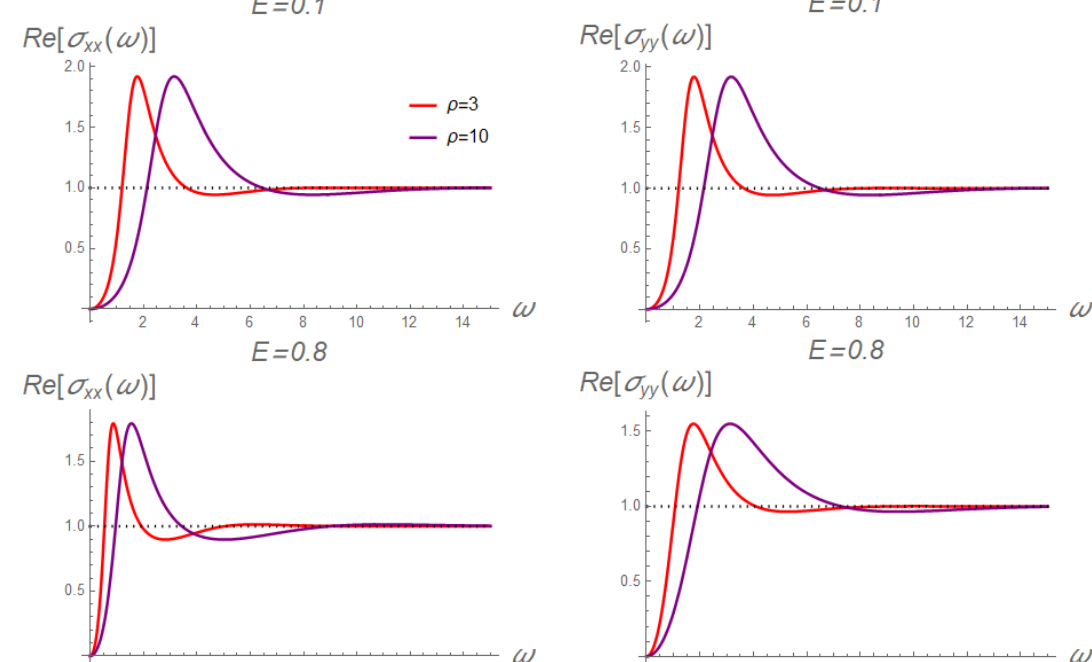
Figure 5 . Real parts of the conductivities for di(cid:11)erent values of electric (cid:12)eld E and charge density (cid:26) in the case E < B (symmetric phase). We do not show the plots of the transverse conductivities since they are just constants in !